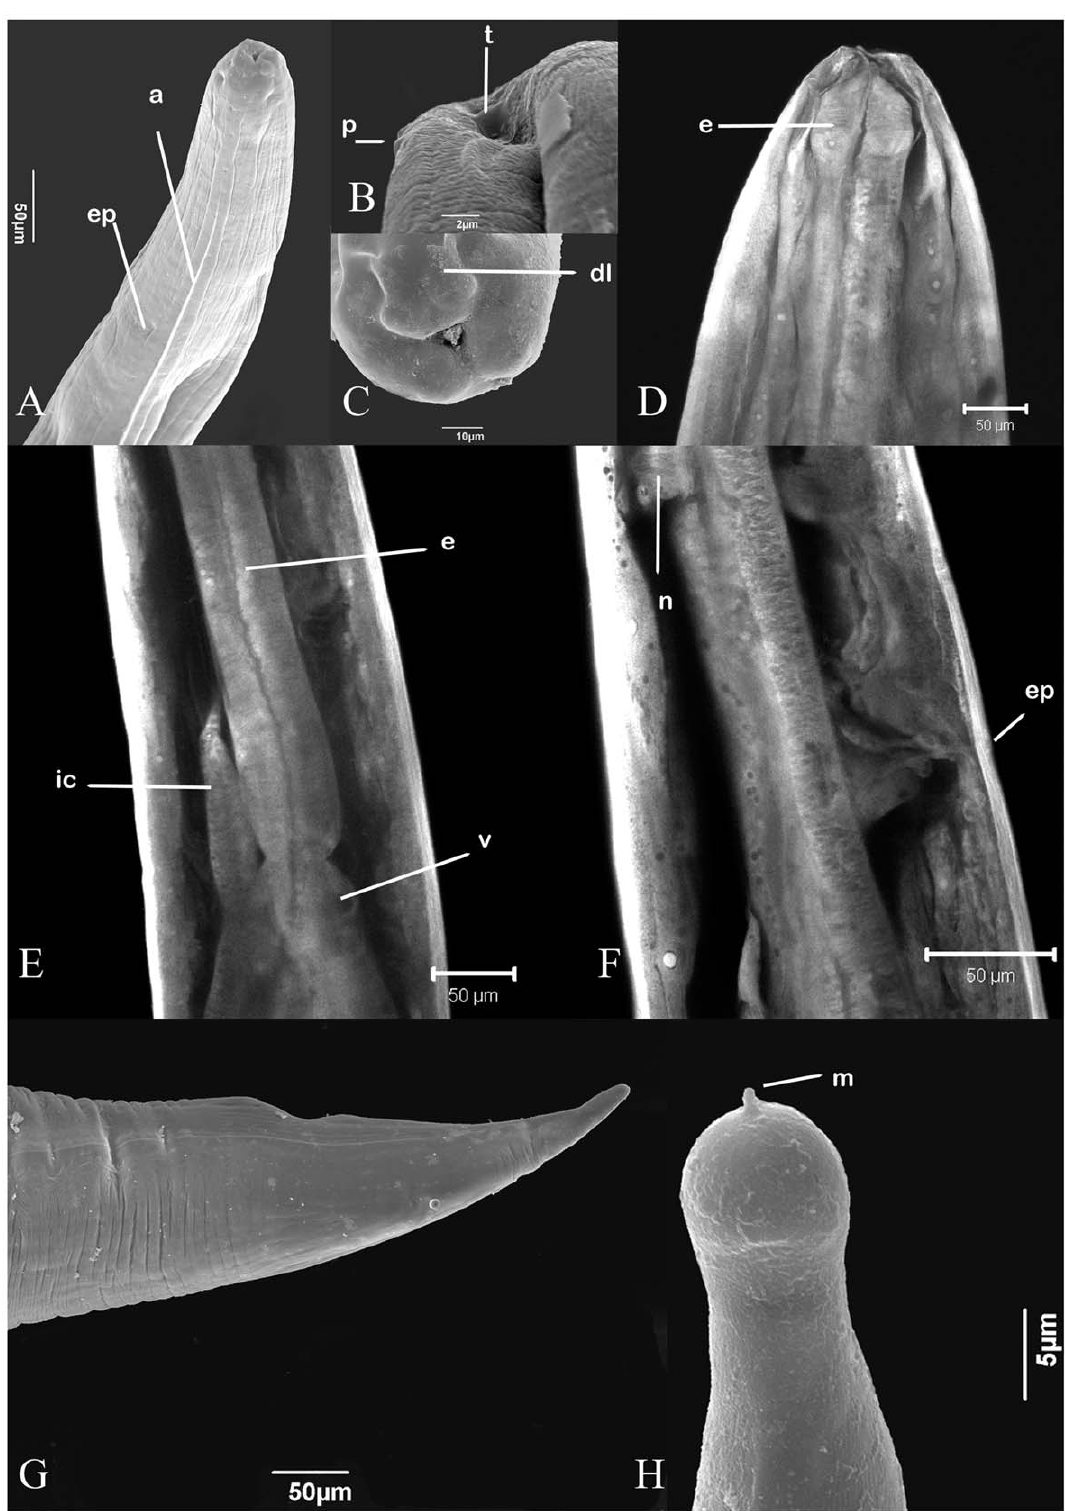
Figure 5. A–H: Hysterothylacium sp. larvae: SEM and CLSM microscopy. A- SEM of anterior end with alae and excretory pore; B- Detail of L3 lips with inconspicuous boring tooth and papillae; C- Detail of lips of L4 with dorsal lip showing double papilla; D- CLSM of esophagus; E- CLSM reconstruction with ventriculus, intestinal caecum and esophagus; F: CLSM reconstruction with nerve ring and excretory pore; G- SEM of tail; H- SEM micrograph with a detail of the digitiform tip with terminal mucron. Abbreviations: a - alae; ep - excretory pore; p – papilla; t - tooth; dl - dorsal lip; e - esophagus; ic - intestinal caecum; v - ventriculus; n - nervous ring and m - mucron.